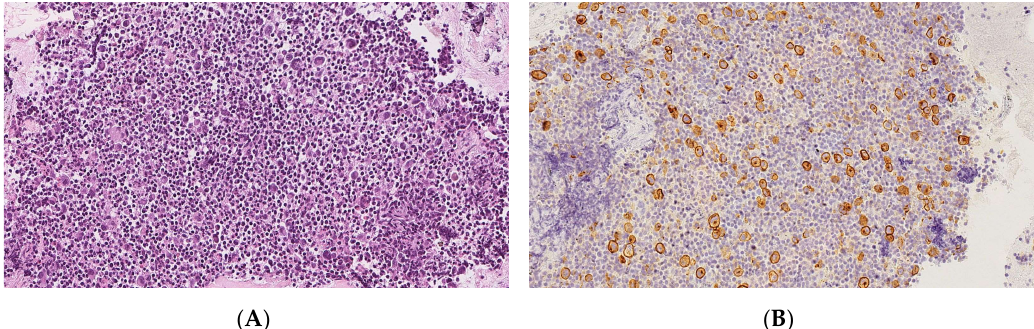
Figure 5. Hodgkin Lymphoma, Classic Type, case 25. Hematoxylin–Eosin CB-stained section shows small lymphocytes, eosinophils and histiocytes mixed to scattered large mononucleated and multinucleated cells (30 × ) ( A ). CD30 highlights large atypical cells (30 × ) ( B ). Diagnostics 2020 , 10 , x FOR PEER REVIEW